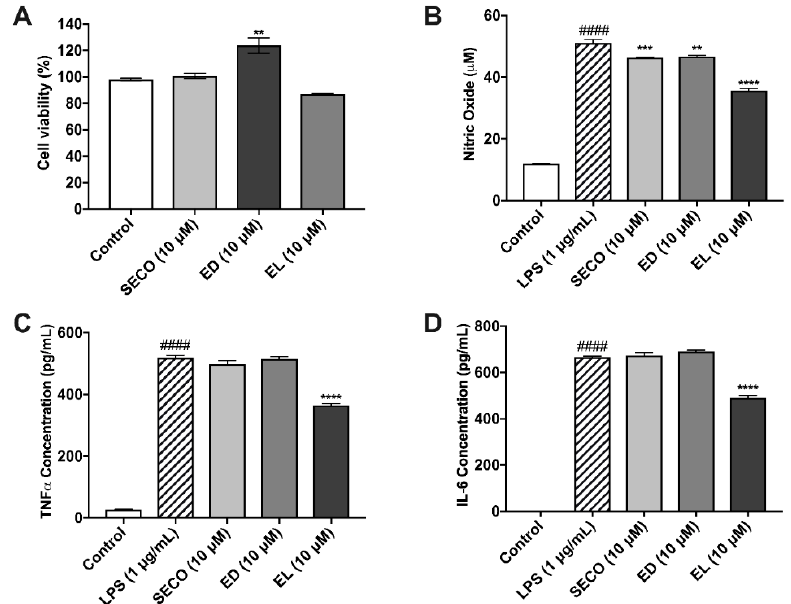
Figure 5. E ff ects of lignans in murine microglia cells. Lignans were evaluated for cytotoxicity in BV-2 ( A ). E ff ect of lignan treatment (10 µ M) on nitric oxide production, as determined by the Griess Reagent ( B ). Lignans reduce the production of pro-inflammatory cytokines in murine microglia, TNF- α ( C ) and IL-6 (D). All data expressed as mean ± standard error ( n ≥ 3), significance was reported by analysis of variance (ANOVA) followed with Dunnett multiple comparison testing. Significance as compared with control p ≤ 0.0001 (####); as compared with LPS, p ≤ 0.002 (**), p ≤ 0.0002 (***) and p ≤ 0.0001